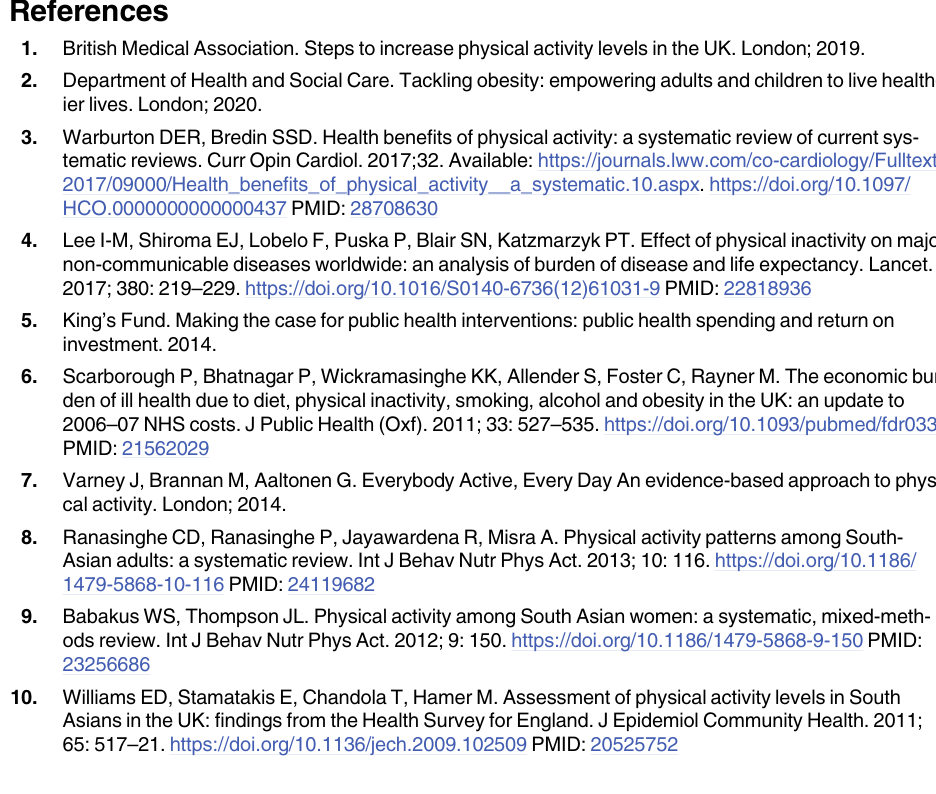
S1 Table. Topics included in interview guide. S2 Table. Emergent themes with place in socioecological model and illustrative